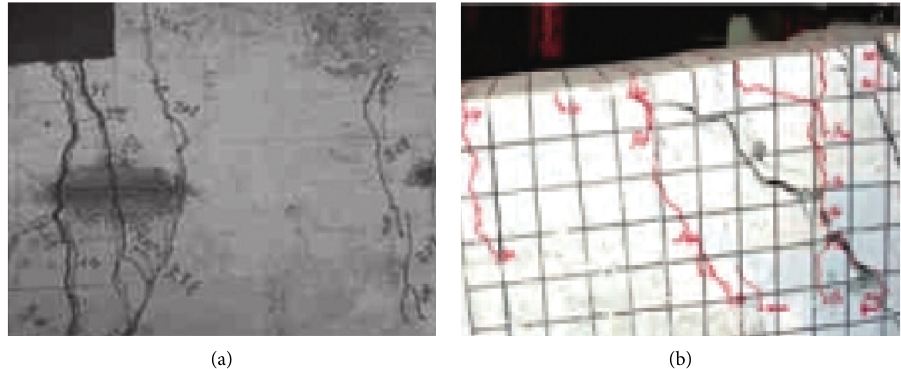
Figure 9: Failure pattern of available beam-girder joints. (a) Xu et al. [3] and (b) Han et al. [4].